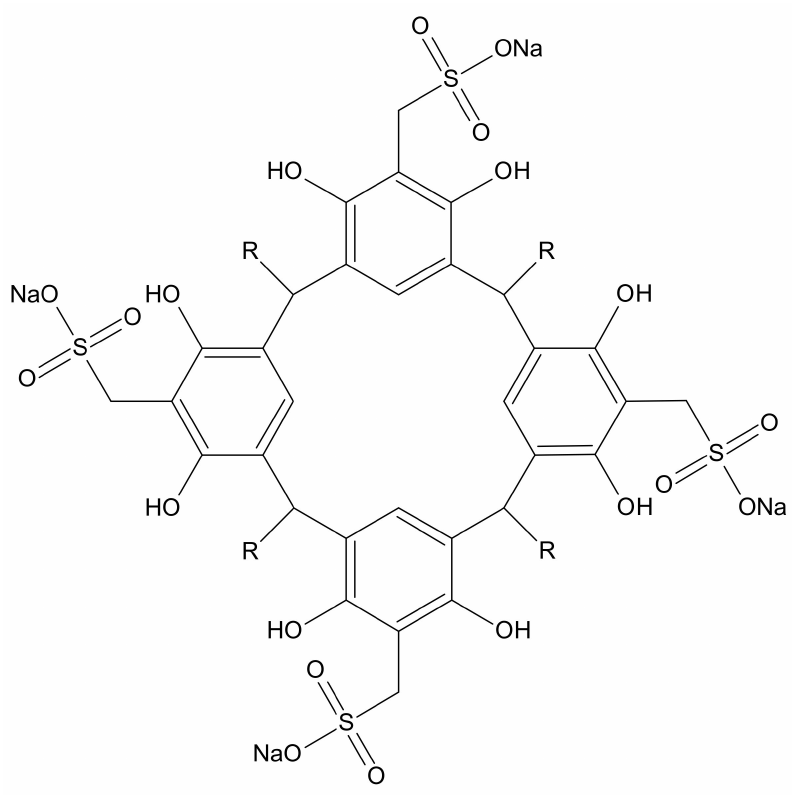
Figure 1. Resorcin[4]arene sulfonate structure (Na 4